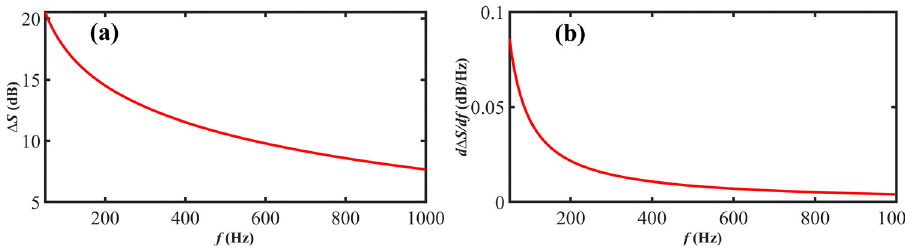
Figure 5. ( a ) The CDSPST and ( b ) variation rate versus under-test laser linewidth. Parameters used in simulation: L = 20 km, n = 1.5.